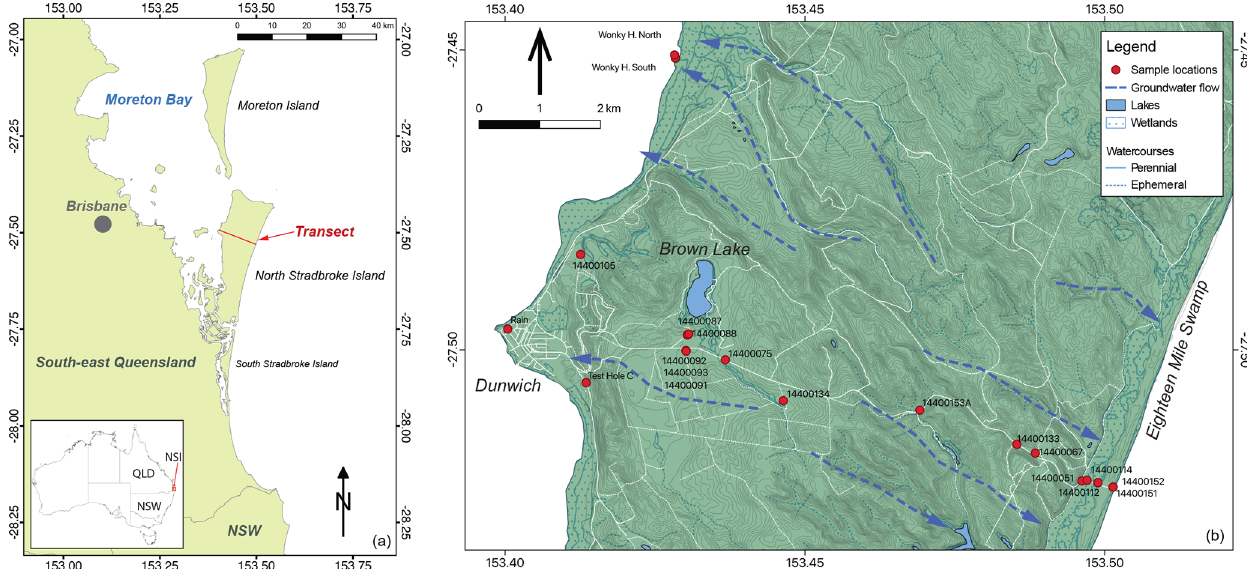
Figure 1. (a) Location of North Stradbroke Island (NSI) in Moreton Bay, Queensland, Australia. (b) Bores sampled (by reference number – RN) along the transect across the island. Blue arrows indicate general flow directions. (Maps were generated using GIS files from the Queensland Government Spatial Catalogue, QSpatial,